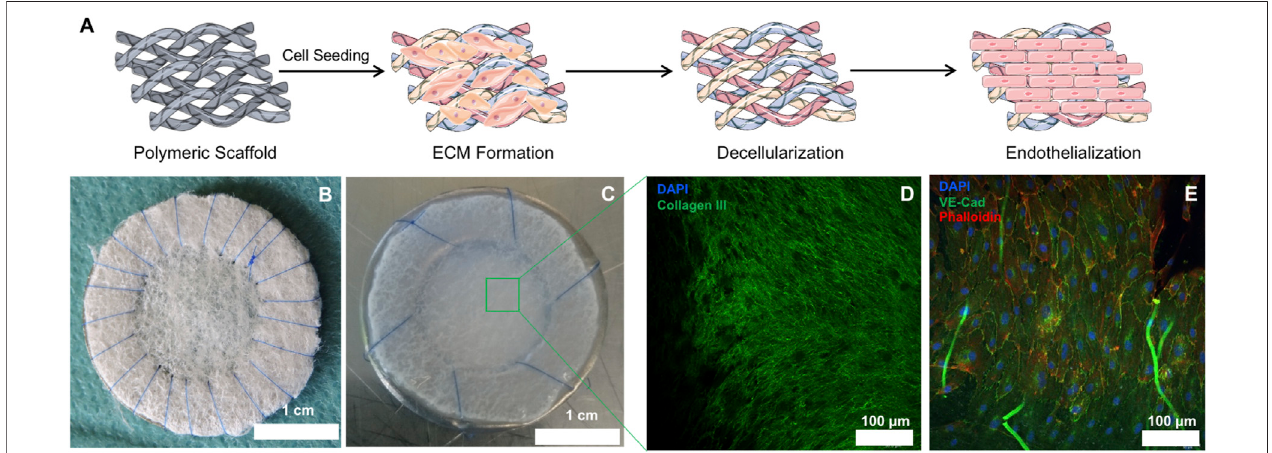
FIGURE1| MacroscopicandmicroscopicappearanceofhTEMsbeforeandafter invitro culture. (A) :SchematicrepresentationofthehTEMproductionprocedure (Images adapted fromServier Medical Artunderacreative commonattribution3.0unported license).Brie fl y,PGA/P4HBscaffoldsweresuturedonstainless-steelmetal ring and seeded with hDFs. After 4 weeks culture, patches were decellularized and fi nally endothelialized in vitro . (B) : Macroscopic image of the PGA/P4HB scaffold sutured onto a stainless-steel metal ring before cell seeding. (C) : Macroscopic appearance of the hTEM resulting from 4 weeks of tissue culture and subsequent decellularization. The hTEM is characterized by a shiny and smooth surface, indicating the presence of ECM. (D) : Confocal microscope image of the hTEM stained for collagenIII(green)andDAPI(blue)revealsthepresenceofadenseandhomogeneouscollagenousmatrixwithcompleteabsenceofcellnuclei. (E) :Confocalmicroscope image showing homogeneous endothelialization on the hTEM